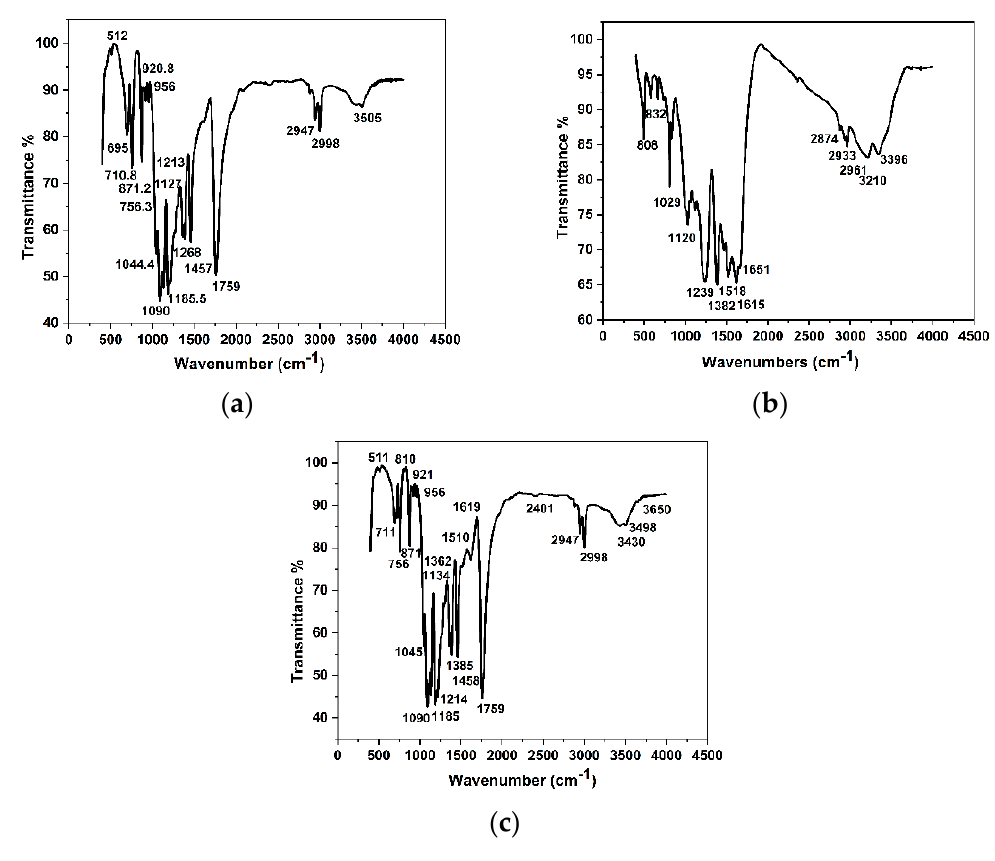
Figure 5. FT-IR of ( a ) PLA, ( b ) COFs, and ( c ) COFs-PLA.